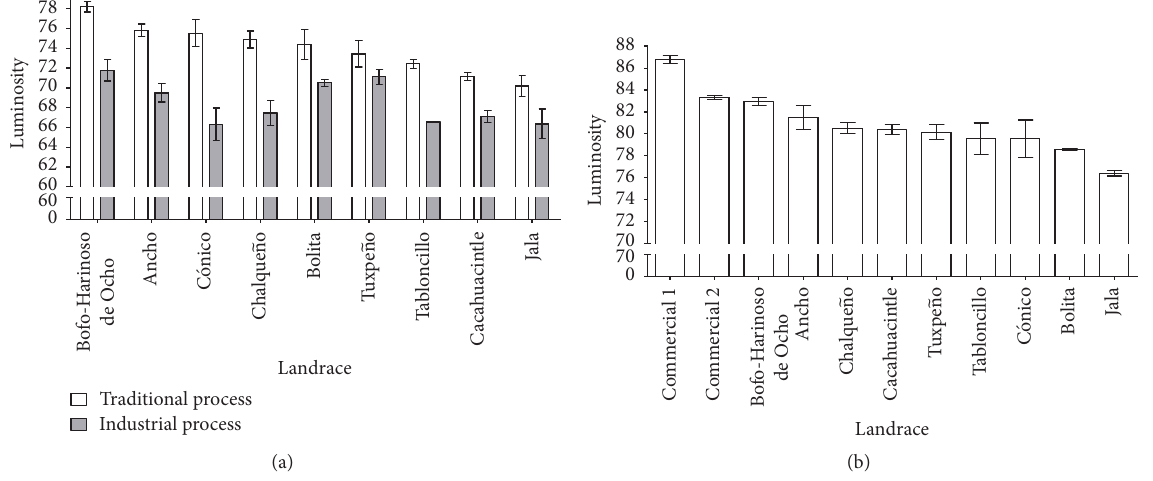
Figure 2: Luminosity of debranned nixtamal (a) and bleached precooked grain (b) from nine maize